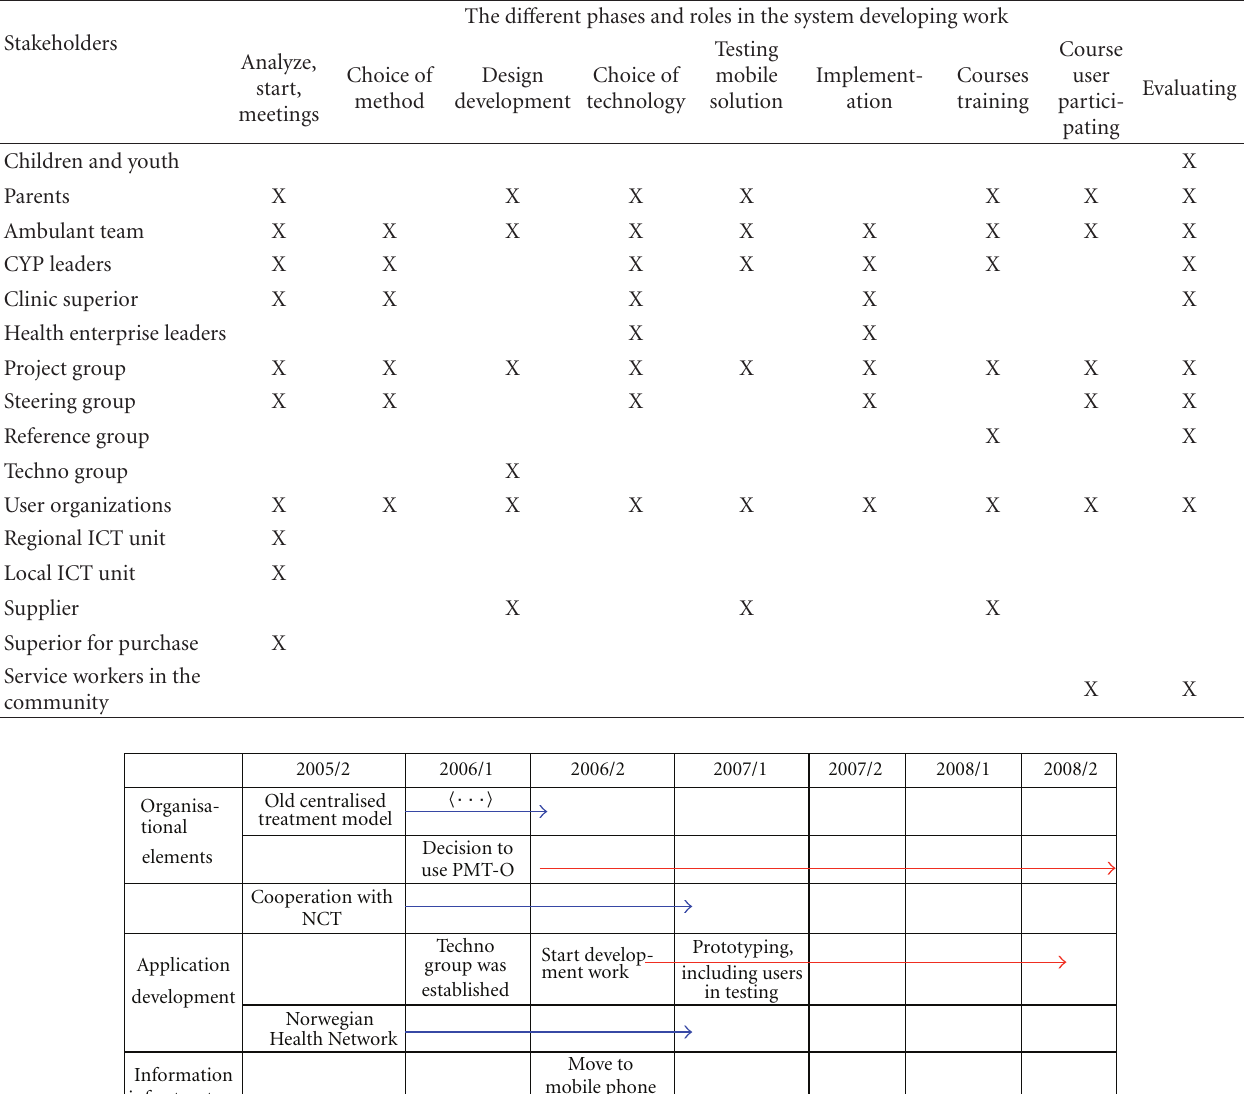
Table 3: Stakeholders, phases, and roles in the system development work.